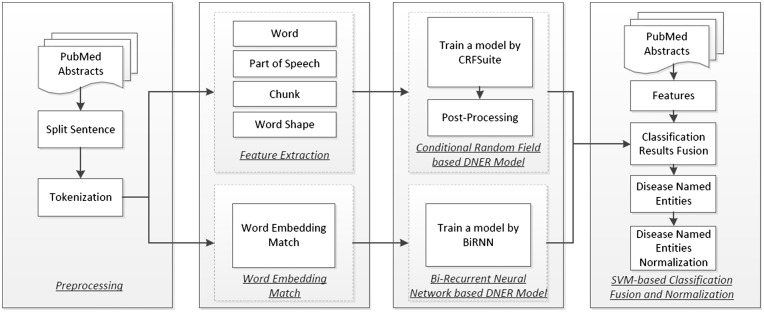
System architecture.